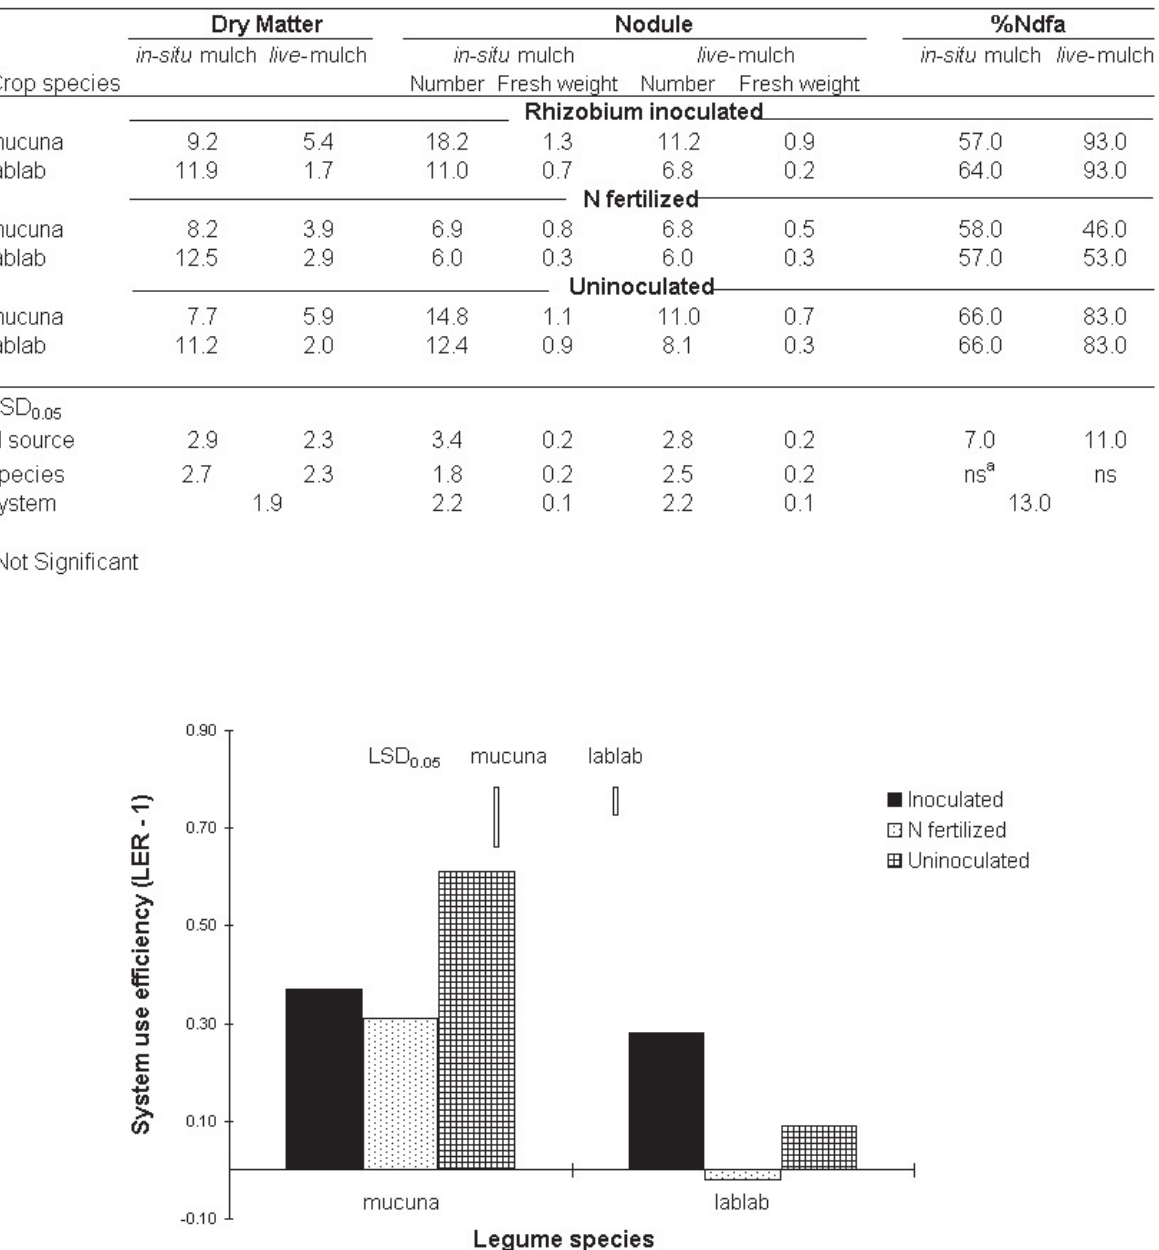
Effect of Rhizobia Inoculation, N Fertilization, and Cropping Systems on Shoot Dry Matter (t DM ha – 1